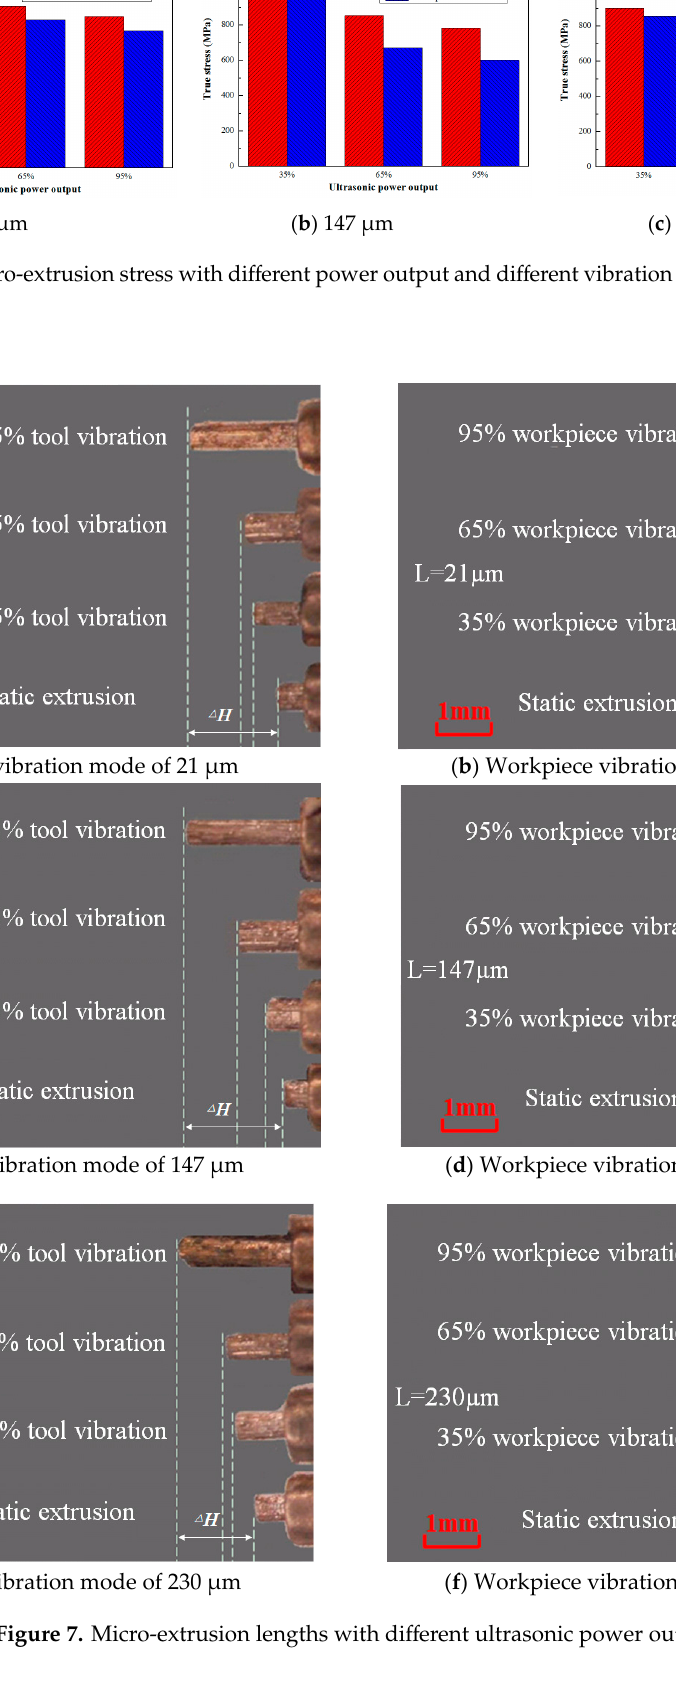
Figure 6. Micro-extrusion stress with different power output and different vibration modes for different grain sizes.